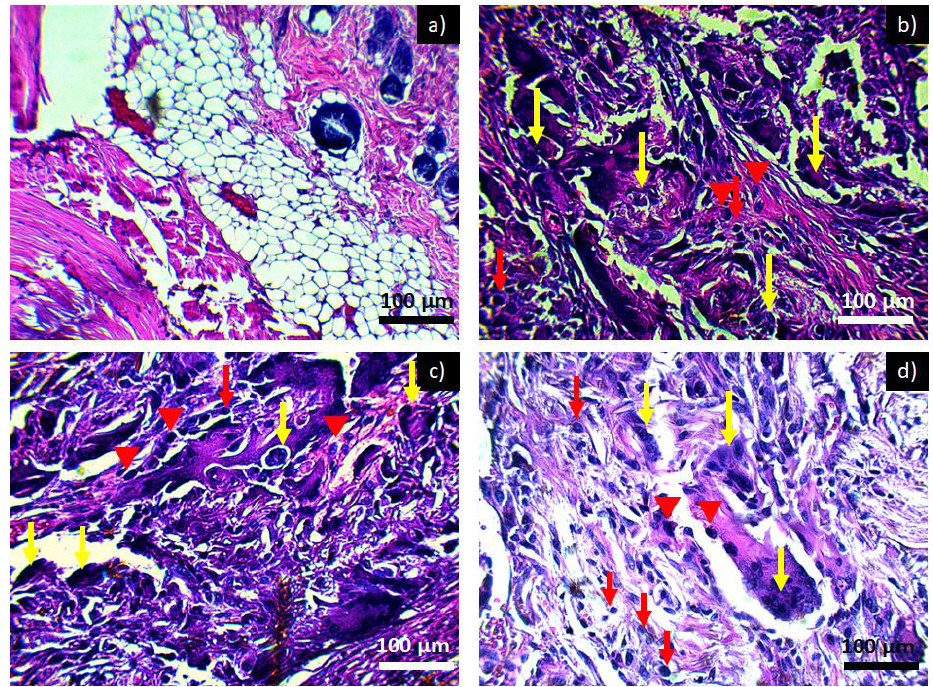
Figure 9. Histological preparation in tissue hematoxylin-eosin with the PCL/HA- α -Al 2 O 3 : ( a ) con- trol, ( b ) PCL/HA- α -Al 2 O 3 2 weeks, ( c ) PCL/HA- α -Al 2 O 3 4 weeks, and ( d ) PCL/HA- α -Al 2 O 3 6 weeks. Red arrows indicate the presence of lymphocytes, red arrowheads indicate macrophages, and yel- low arrows indicate the presence of multinucleated giant cells characteristic of a chronic inflamma- tory infiltrate.